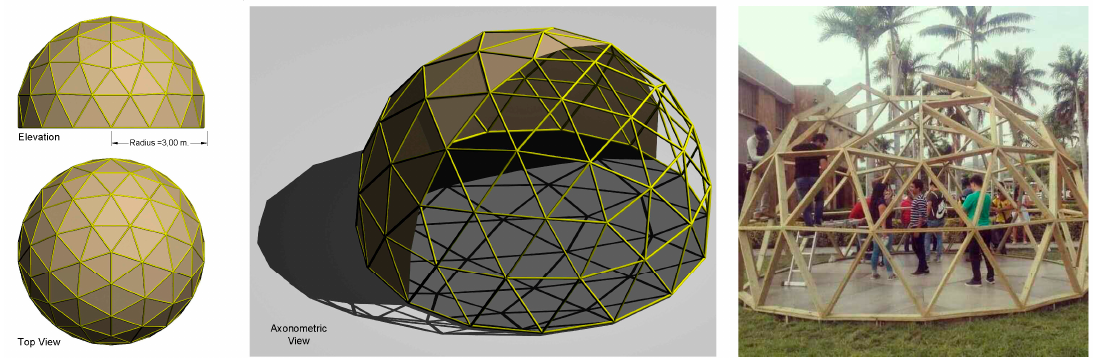
Figure 1. Structure of the geodesic dome. The left and central pictures show different views of the internal structure, and the right picture shows its building